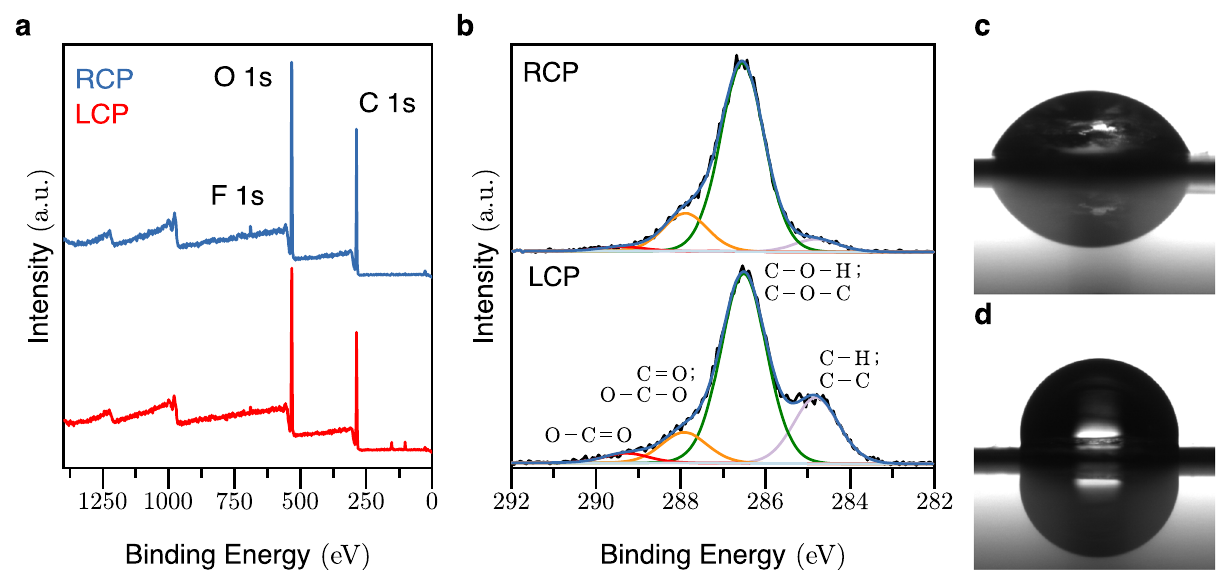
Fig. 5 Solid fi lms XPS and wettability measurements. a Wide-scan X-ray photoelectron spectra (XPS) survey spectrum of solid fi lms prepared from left- handed (LCP) and right-handed (RCP) liquid crystalline quasi-2D solutions, the presence of TFA ester can be noticed for RCP fi lm. b Core level C 1 s XPS spectra and the respective deconvoluted peaks for RCP and LCP samples. The contribution of the peaks from C – H, C – C (hydrophobic cellulose groups) signi fi cantly reduces from LCP to RCP samples, while the area of the peaks assigned for O – C – O, C = O (hydrophilic cellulose groups) and C – O – H and C – O – C increase for RCP sample. c Water droplet on the more hydrophilic RCP surface and in d on the less hydrophilic LCP